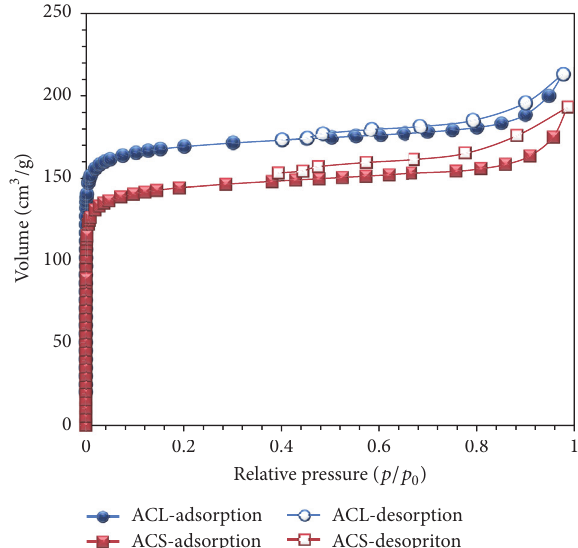
Figure 1: Low-temperature nitrogen adsorption isotherms, at − 196 ∘ C, obtained from ACL and ACS samples.